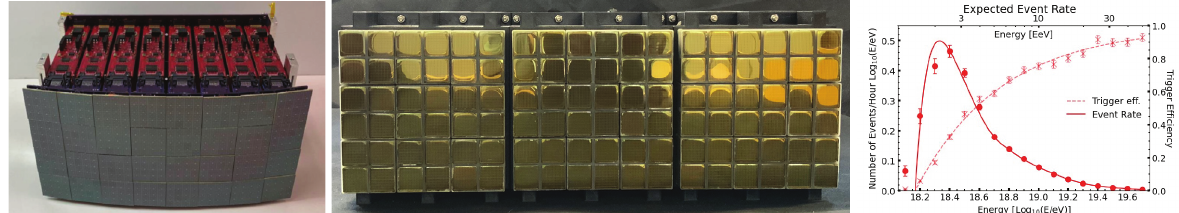
Figure 9. Left: SiPM and electronics modules of the CT camera of EUSO-SPB2. Center: focal surface of the FT of EUSO-SPB2, with 3 PDMs for a total of 6912 pixels. Right: expected trigger e ffi ciency for cosmic-ray events in the FT of EUSO-SPB2 and the corresponding event